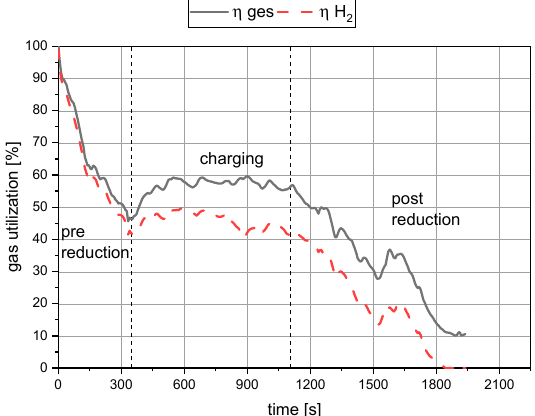
Figure 9. Total gas utilization and hydrogen gas utilization for trial B50/C1.04.